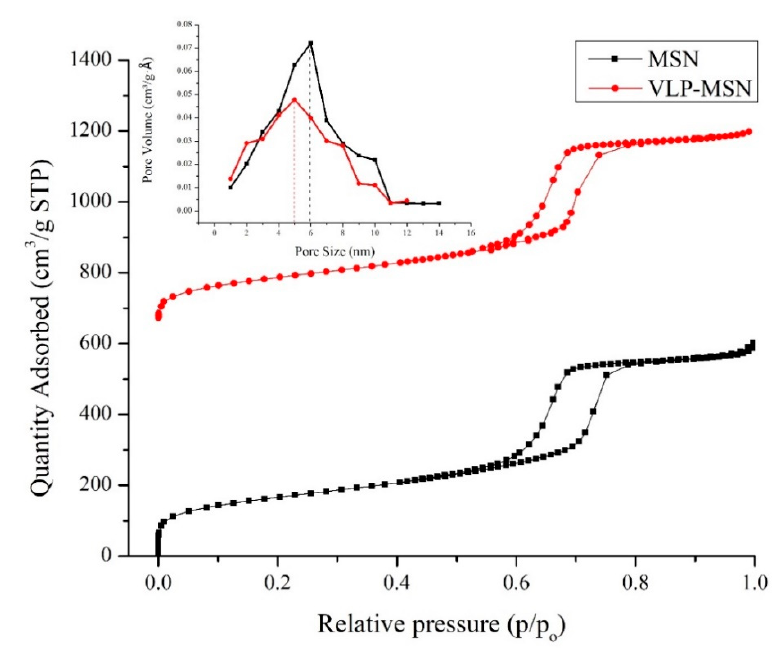
Figure 2. N 2 adsorption-desorption isotherms of MSN and VLP-MSN. Inset picture shows pore diameter of MSN and VLP-MSN.